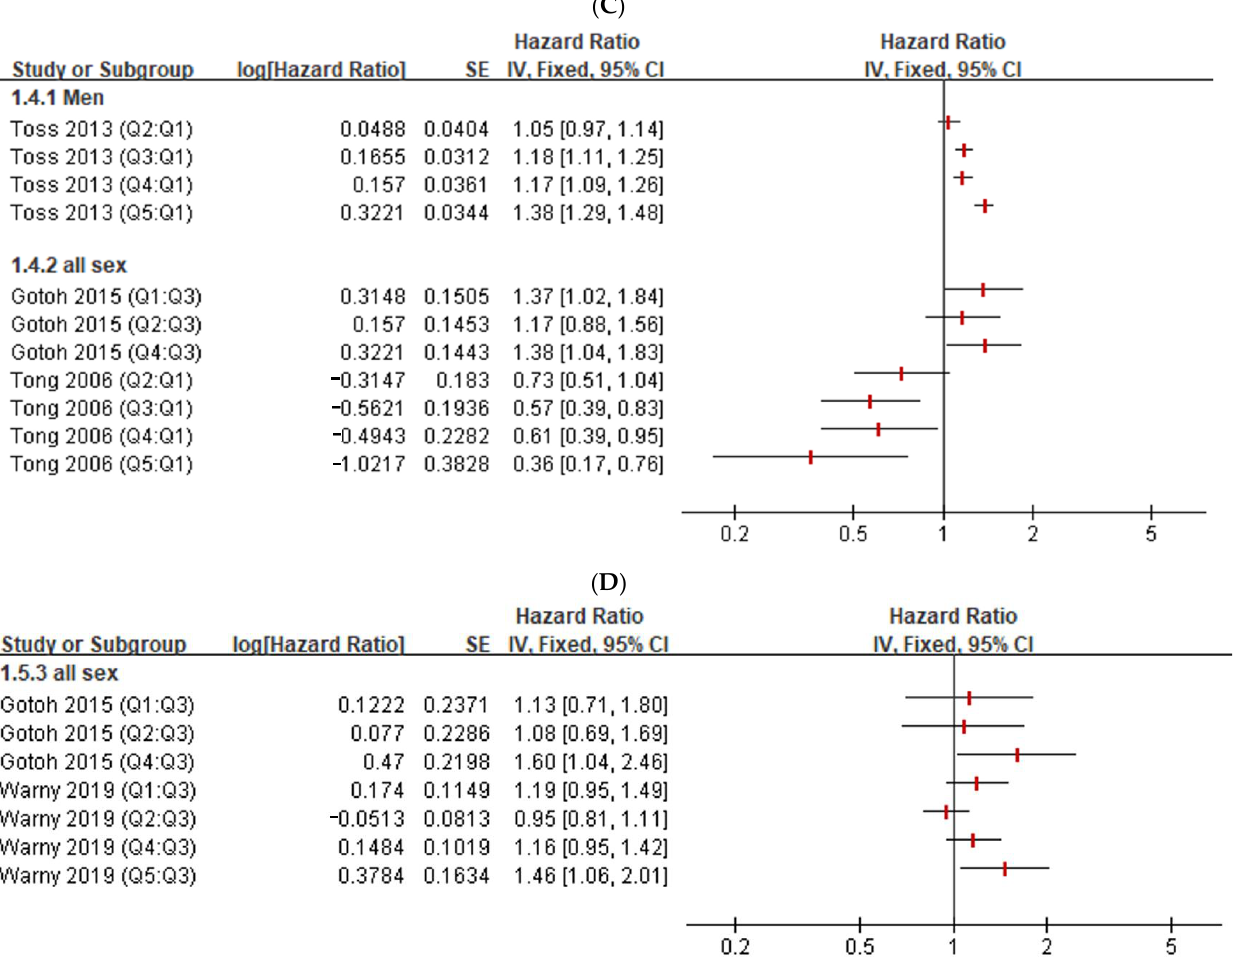
Figure 2. The association between hematocrit levels and diseases related to embolism. ( A ) Mortality (all cause, acute myocardial infarction, or acute stroke-related) [22,24,28]; ( B ) ischemic stroke [26,27,29]; ( C ) cardiovascular diseases (include arterial embolism in the heart or brain) [23,25,26]; ( D ) coronary heart disease [26,29]. SE = standard error; IV = inverse variance; CI, confidence interval * Note: the effect size for Brown’s (2001) study was a relative risk rather than the hazard ratio in other studies.